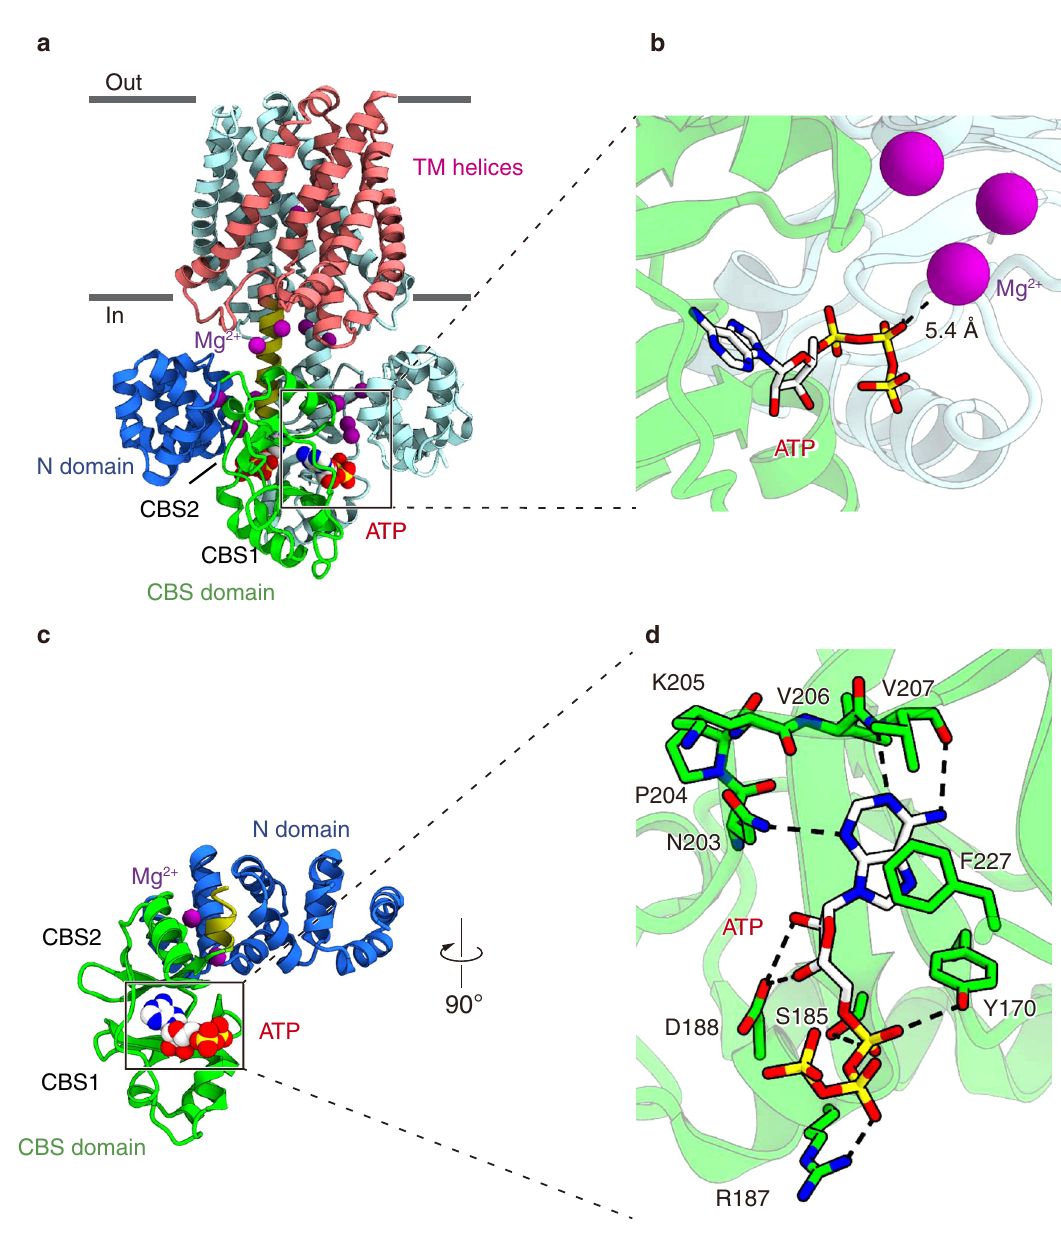
Fig. 3 Overall structure and ATP binding site of MgtE. a Ribbon representation of the full-length MgtE structure in complex with ATP, viewed parallel to the membrane. The N domain, CBS domain, plug helix, and transmembrane helices in one subunit are colored blue , green , yellow , and red , respectively. ATP and Mg 2+ are shown as sphere models a , c . b Close-up view of the ATP binding site in the full-length structure. The dotted black line represents the minimum distance between the β -phosphate group of ATP and Mg 2+ (5.4 Å). ATP is shown as a stick model b , d . c Ribbon representation of the MgtE cytosolic domain structure in complex with ATP. d Close-up view of the ATP binding site in the MgtE cytosolic domain structure. Amino acid residues involved in ATP-binding are shown as stick models. Dotted black lines indicate the hydrogen bonds between MgtE and